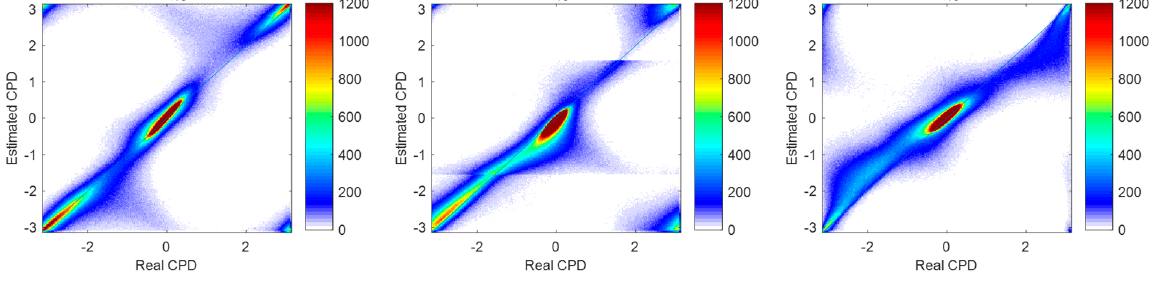
14 of 20 Table 2. Quantitative evaluation for log〈|(cid:1845) (cid:2892)(cid:2906) | (cid:2870) 〉 and CPD by using the root mean square error (RMSE) and the percentage of pixels deviating from the real values by 5% of the total range. Three CP modes illustrated are ((cid:2016) = π /4,(cid:2031) = 0) , ((cid:2016) = π/4,(cid:2031) = π /8) , and ((cid:2016) = π/4, (cid:2031) = π /4) . Data Sets